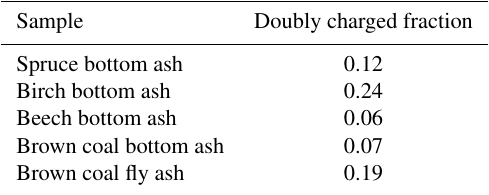
Table 1. Fractions of doubly charged particles generated from dry sample material as determined from UHSAS measurements. The selected particle size was 300nm. The fraction of particles with three or more negative charges was determined to be in the range of 1% for all samples and hence